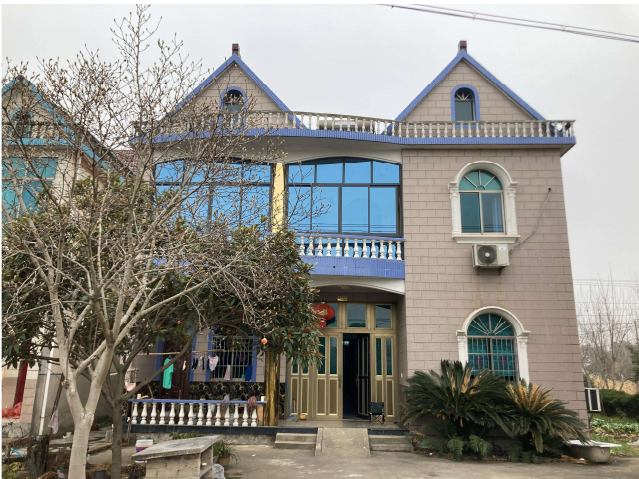
Figure 9. The field survey object. Table 4. Basic information about the residence.